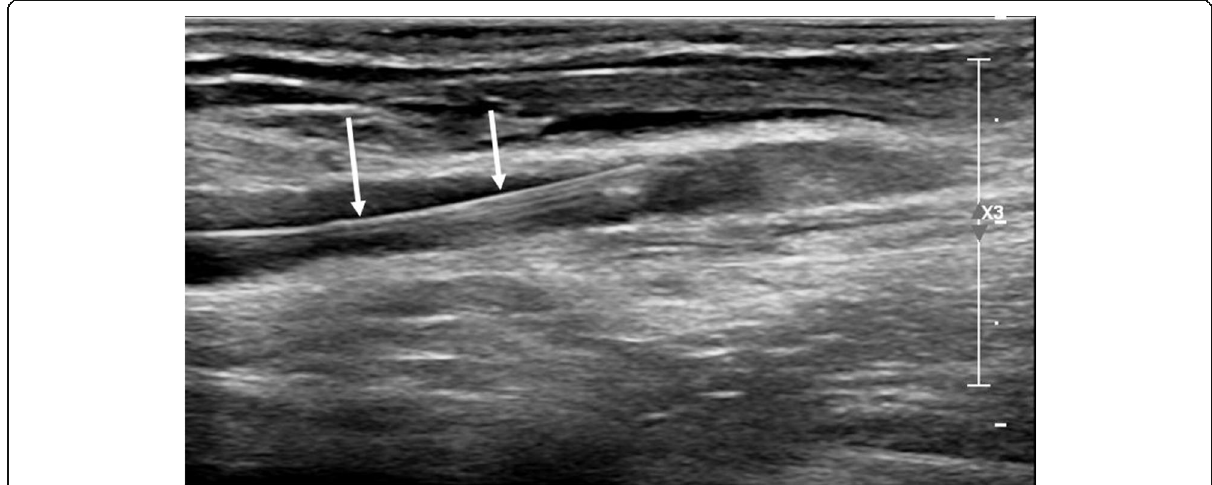
Fig. 2 Longitudinal ultrasound picture of 19G puncture needle and guidewire (white arrows), which was inserted under live ultrasound